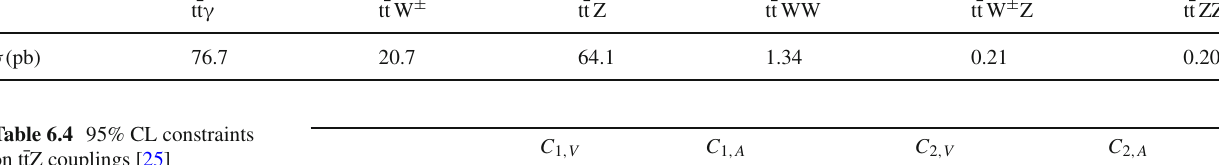
Table 6.4 95% CL